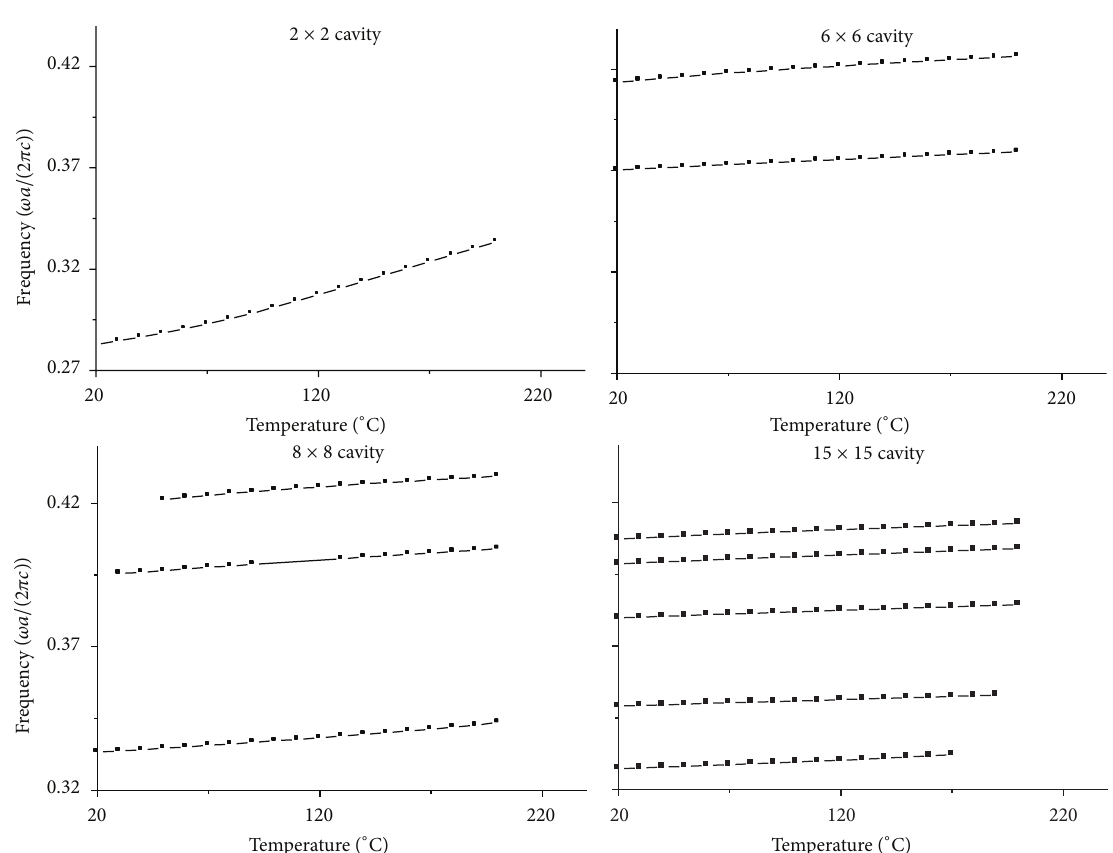
Figure 4: The resonant frequency for 𝑛 × 𝑛 cavity change with temperature. 2 × 2 , 6 × 6 , 8 × 8 , 15 × 15 represent cavities with 𝑛 rows and 𝑛 columns removed.